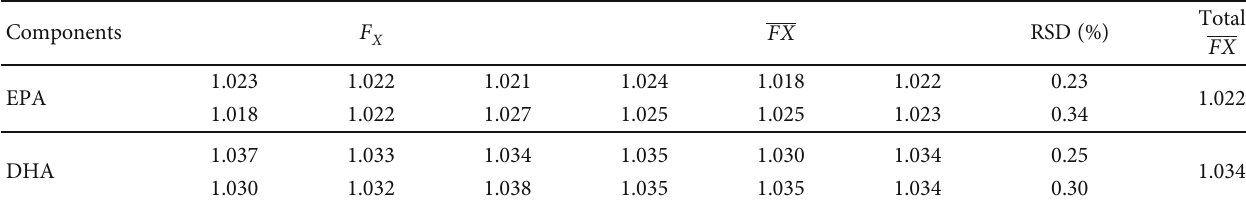
Table 1: Relative correction